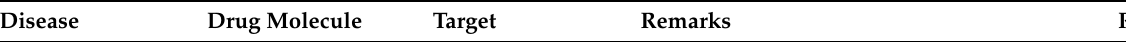
Table 1. Current scenario of the development of mRNA vaccine